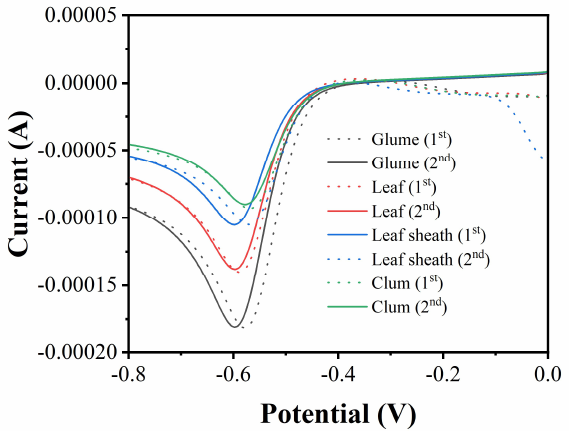
Figure 4. LSV curves of Ag/Si/GCEs prepared using glume, leaf, leaf sheath and culm for electrocatalytic reduction of 0.5 mM H 2 O 2 in 0.1 M PBS (pH = 7.0).